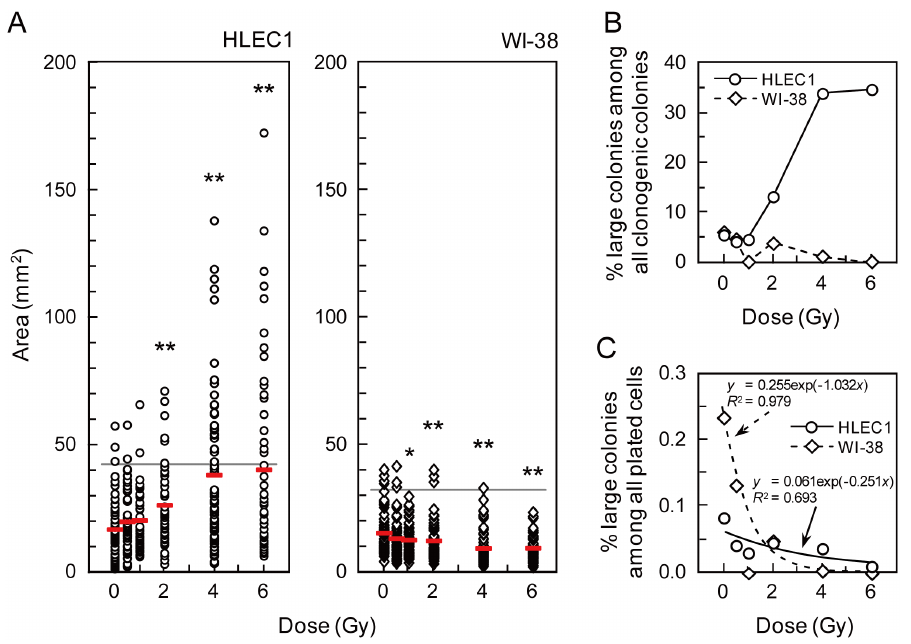
Figure 5. The area of clonogenic colonies. (A) The area distribution of clonogenic colonies arising from HLEC1 (left panel) and WI-38 (right panel) as a function of dose. The area of clonogenic colonies (45–68 colonies for HLEC1 and 54–93 colonies for WI-38 per dose point) was measured as described in Figure S1. Red bars indicate the means at each dose point. The horizontal lines indicate the mean + 2SD area in sham-irradiated controls (41.7 mm 2 for HLEC1 and 31.7 mm 2 for WI-38). *0.01 # p , 0.05 and ** p , 0.01 compared with sham-irradiated controls. See Figure S2 for the frequency distribution replotted as a function of the area. (B) The fraction of clonogenic colonies exceeding the mean + 2SD area of sham-irradiated controls among all clonogenic colonies analyzed. (C) The fraction of clonogenic colonies exceeding the mean + 2SD area of sham-irradiated controls among all plated cells. Curves were fitted to the exponential equation, though the data points for 1 Gy and 6 Gy for WI-38 were excluded because of zero values. R 2 , correlation coefficient square. When the intercept of the exponential curve for WI-38 was changed from 0.255 to 1, its slope changed from 1.032 to 0.716, and changed from 0.979 to 0.994. For Figure 5B and 5C, circles with solid lines and diamonds with dotted lines indicate the data for HLEC1 and WI-38,